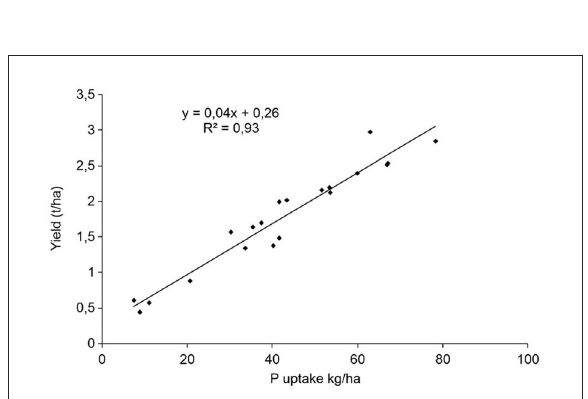
FIGURE5 Relationship between P uptake and yield on a soybean cropping system.